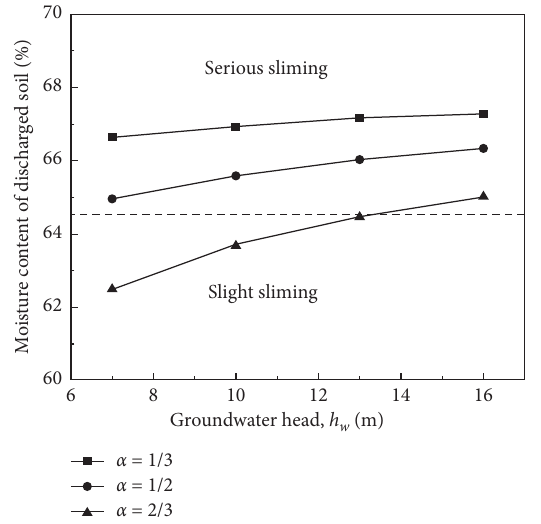
Figure 14: Influence of h w on the moisture content of chamber soil when t � 4h/ring and k � 10 − 5 m/s. Table 4: Reference value and change range of each